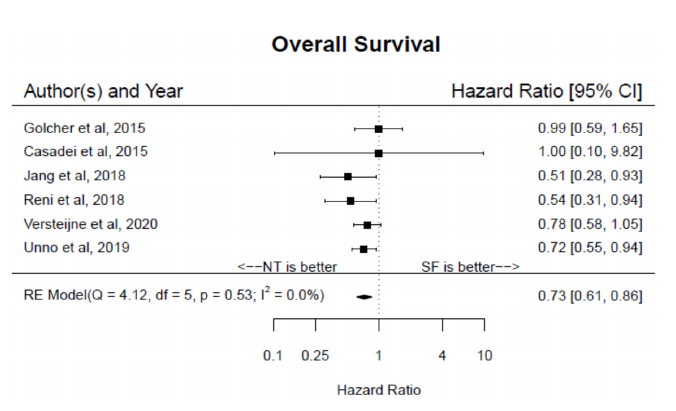
Figure 2. Forest plot of pooled hazard ratio for overall survival among patients with pancreatic cancer randomized to neoadjuvant therapy versus surgery first.